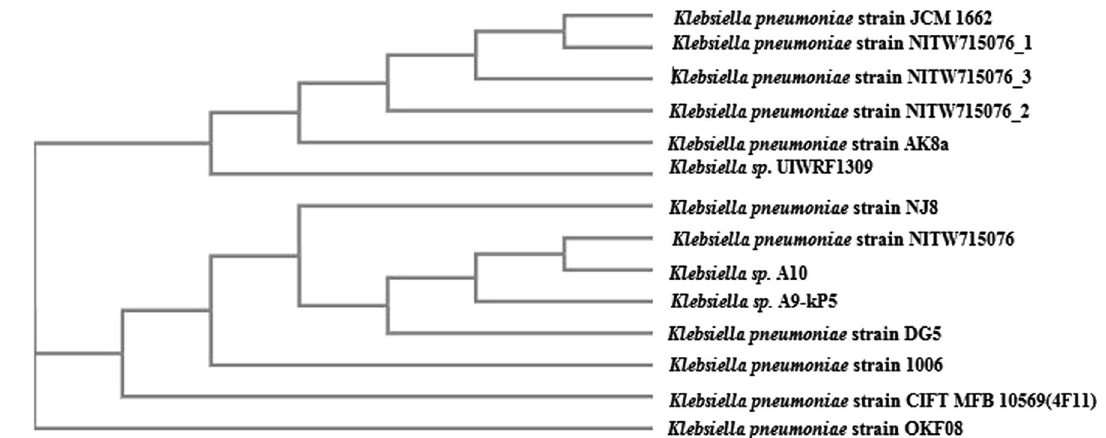
Fig. 1 Phylogenetic dendrogram based on the 16S rRNA sequencing